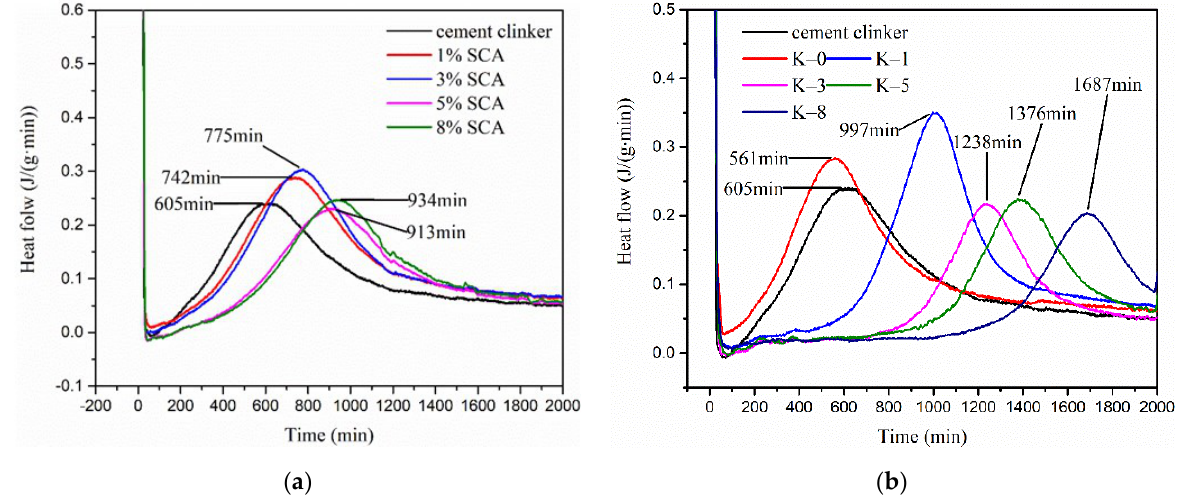
Figure 6. Different additions of silane coupling agent on the heat flow of ( a ) pretreated clinker paste without PVP film and ( b ) autolytic clinker microsphere paste with PVP film.